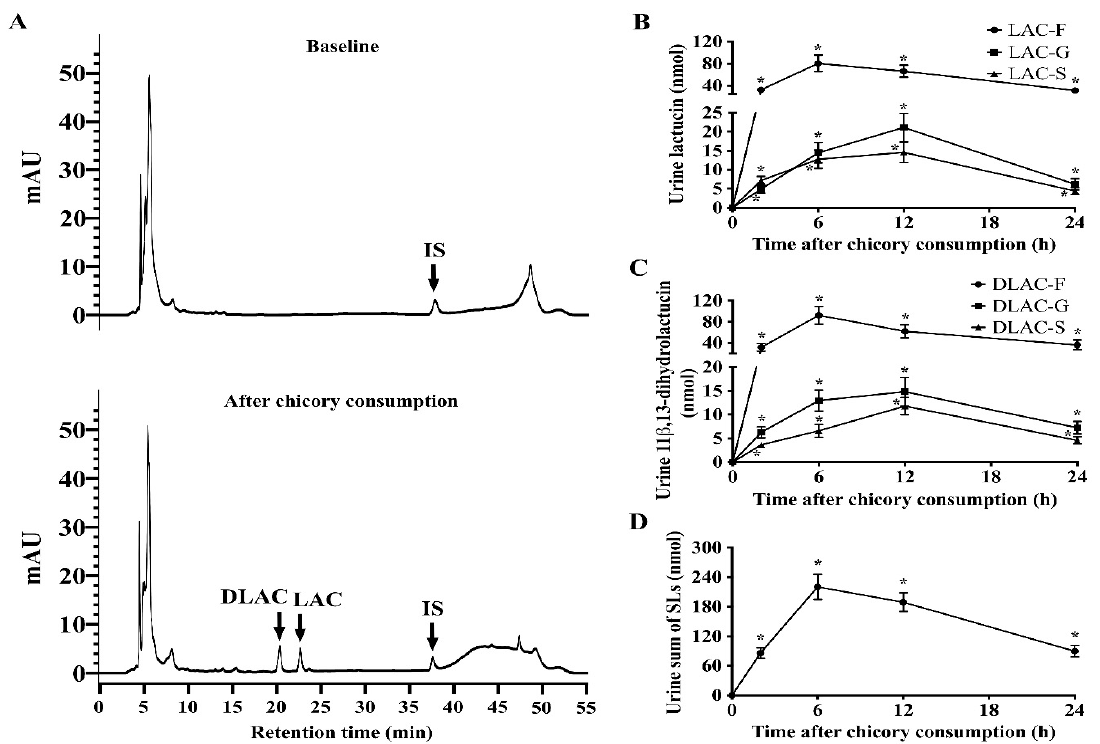
Figure 3. Urine contents of sesquiterpene lactones and metabolites over 24 h in 16 healthy adults after Brussels / witloof chicory consumption. ( A ) Representative chromatographic profiles of free sesquiterpene lactones in human urine sample collected at baseline ( A , top) or at 2–6 h after the consumption of Brussels / witloof chicory ( A , bottom). ( B – D ) Urine excretion of free and glucuronide / sulfate conjugated LAC ( B ), DLAC ( C ), and the sum total of sesquiterpene lactones ( D ). Values are the means ± SEM, n = 16. * Different from baseline, p < 0.05. SLs, sesquiterpene lactones; LAC, lactucin; DLAC, 11 β ,13-dihydrolactucin; IS, internal standard; F, free; G, glucuronide; S, sulfate.